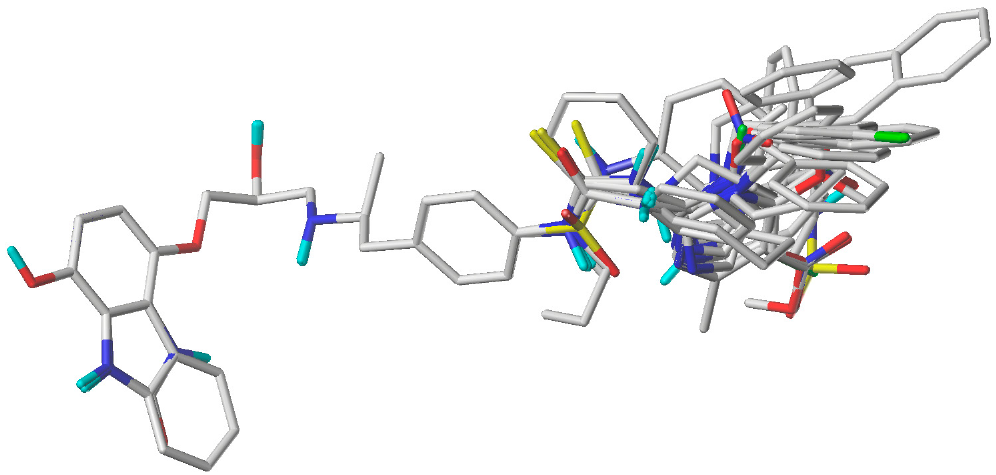
Figure 5. The superimposed structures of all compounds used in the CoMFA/CoMSIA models.